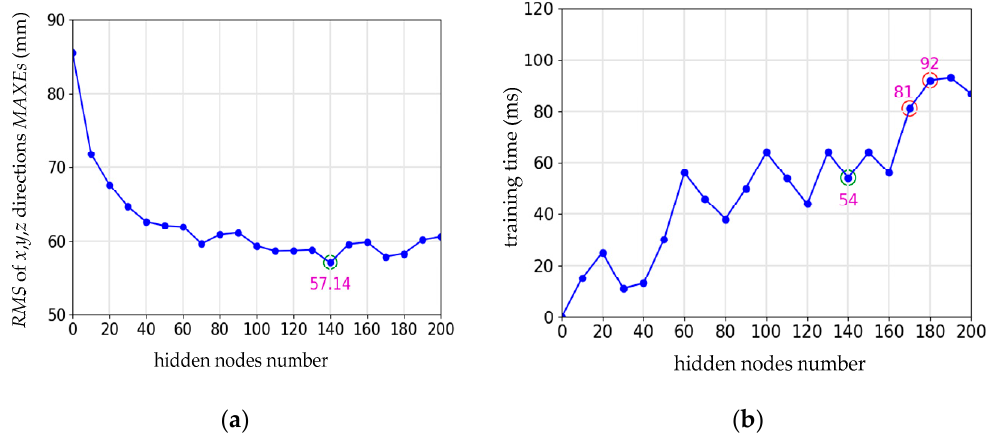
Figure 7. Selection of hidden nodes: ( a ) effect of maximum absolute error ( MAXE ) on hidden nodes number; ( b ) effect of training time on hidden nodes number.